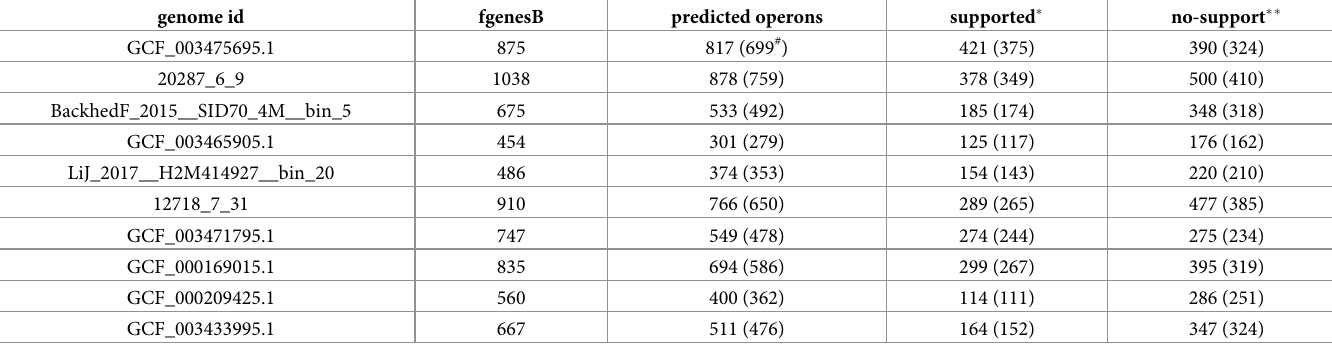
� , �� putative operons with and without spectral support, respectively. # numbers in parentheses reflect the number of operons that overlap with fgenesB predictions (we considered that two operons overlap if half of the smaller operon overlaps with the larger